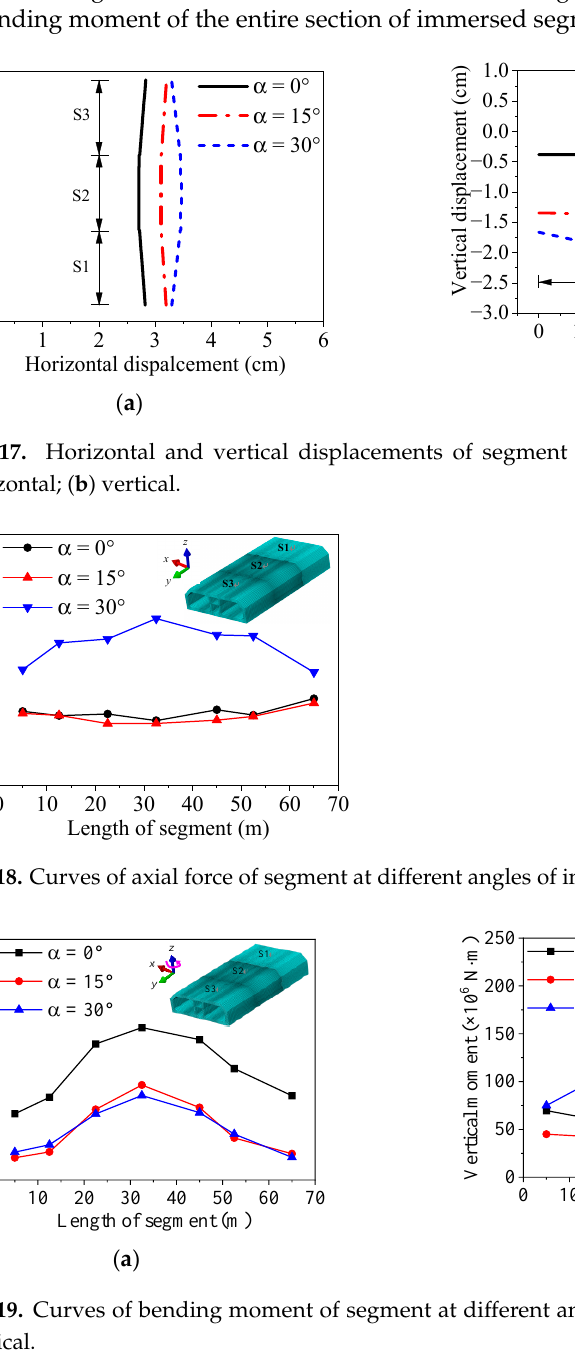
Figure 18. Curves of axial force of segment at different angles of incidence.